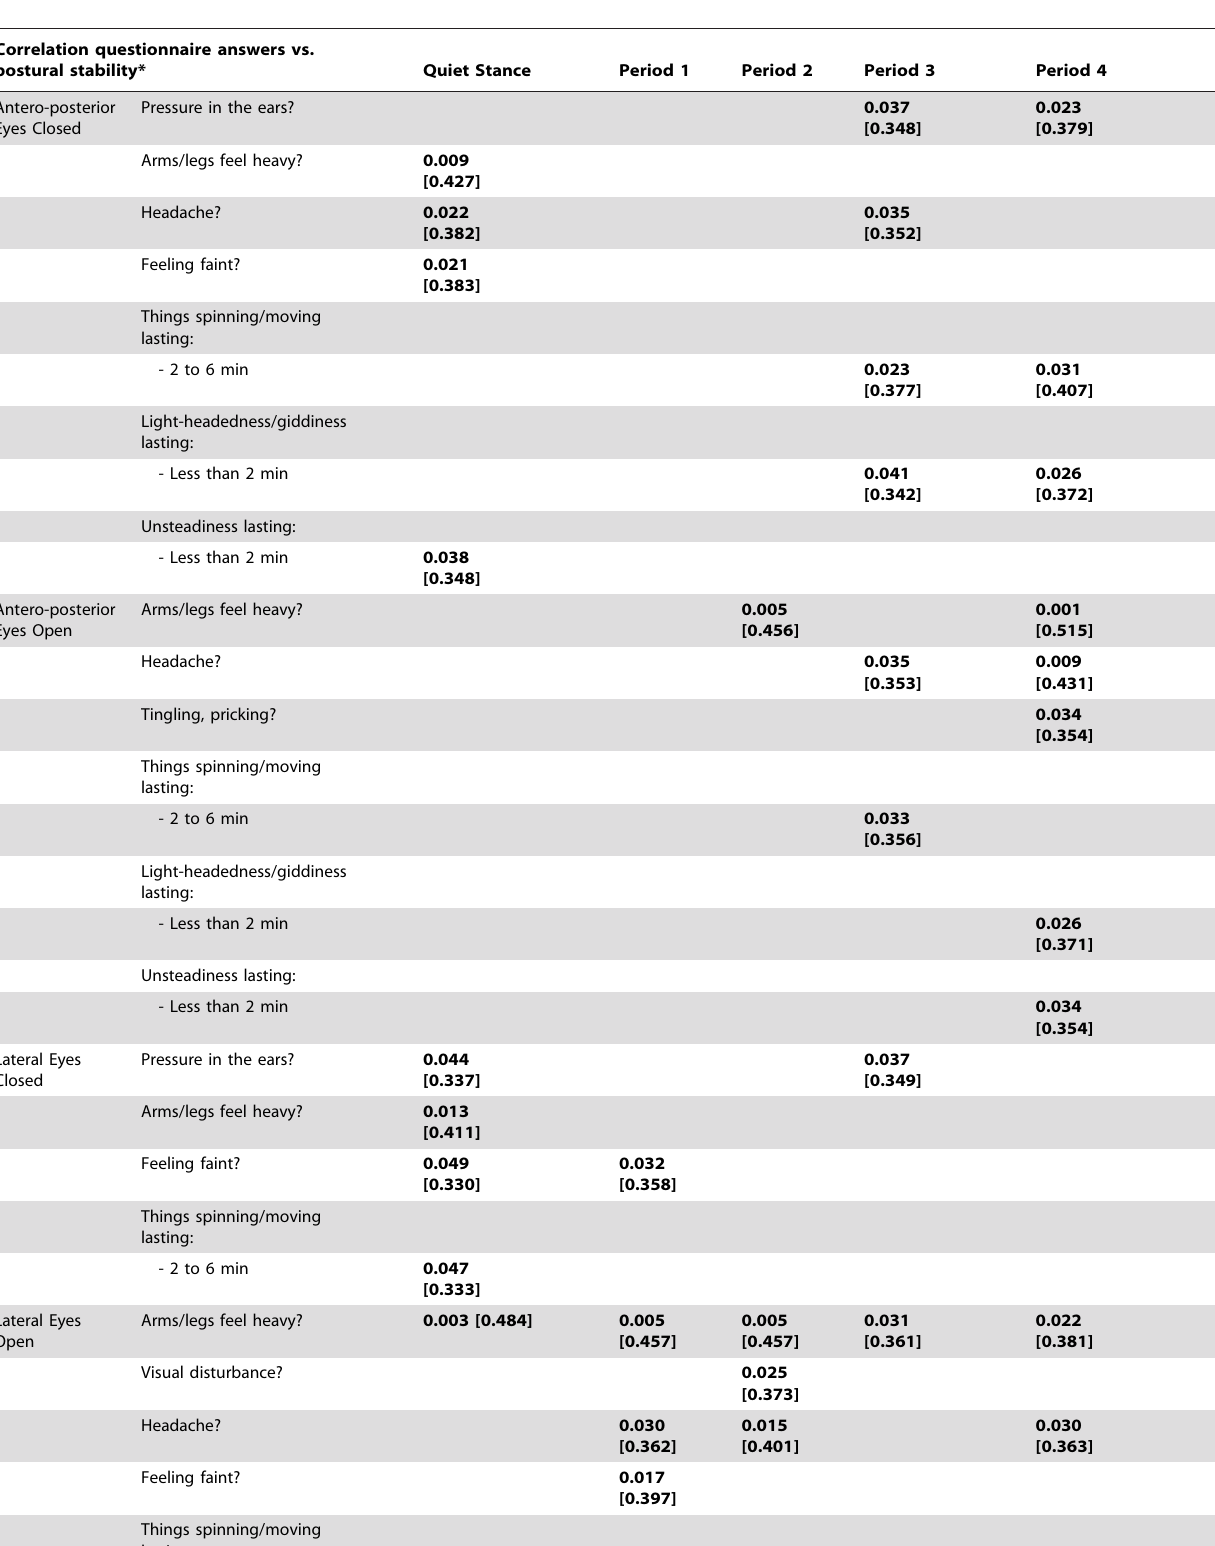
Table 6. Significant correlations between answers to the questionnaire and postural stability in anteroposterior and lateral direction with eyes closed and eyes